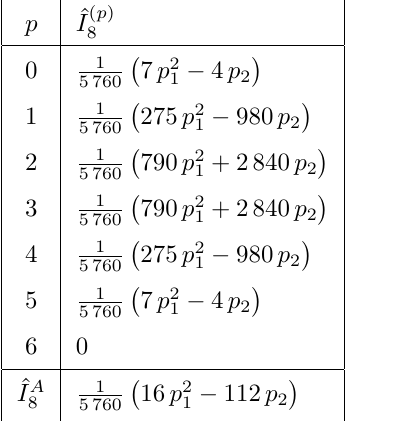
Table 6 . The eight-form anomaly polynomials for chiral fermionic p -forms in D = 6